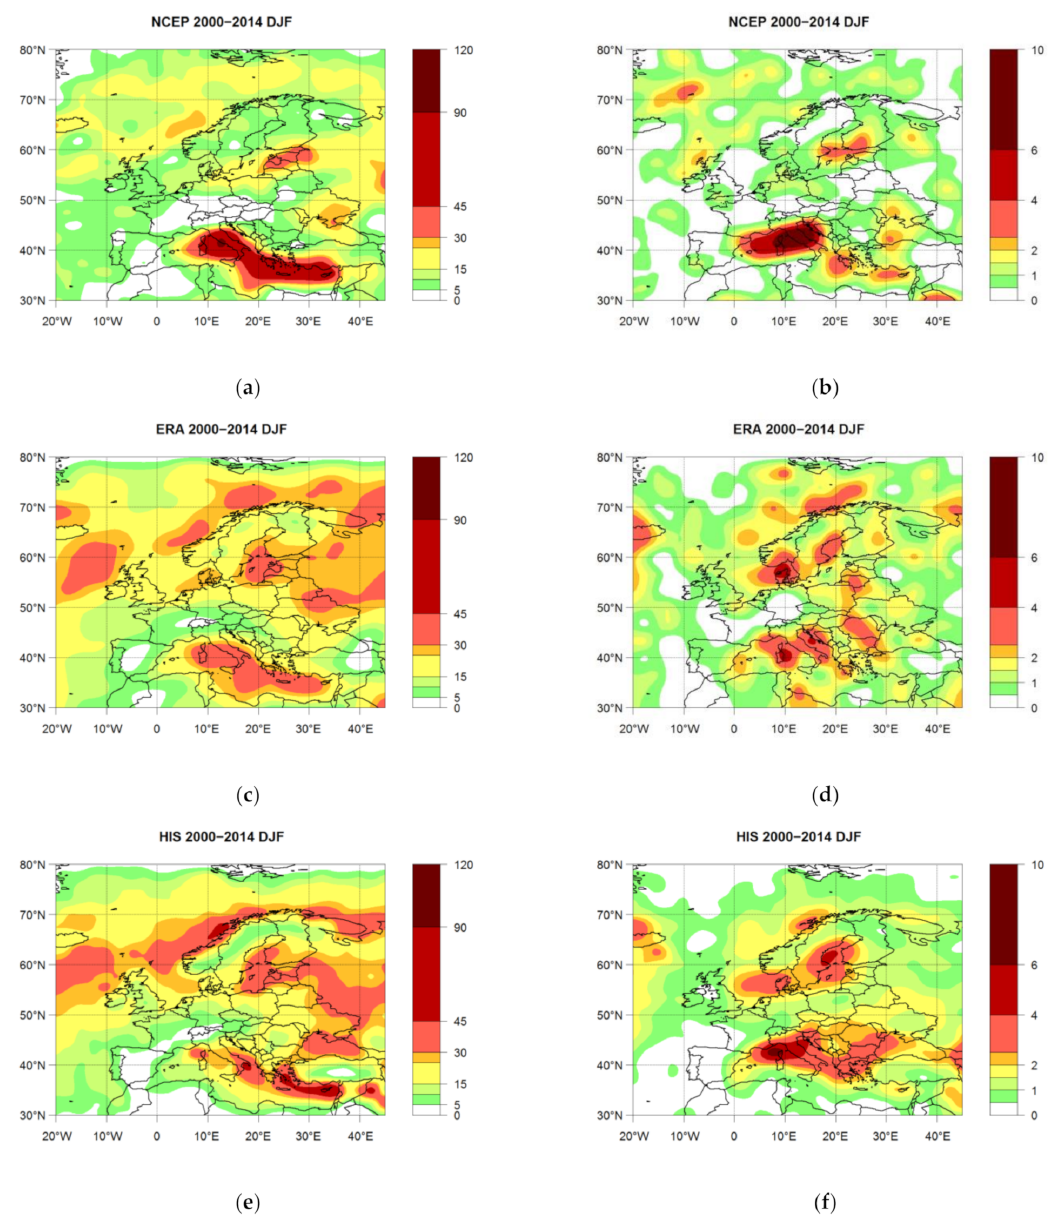
Figure 2. Winter cyclone numbers (total for 15 seasons) in the recent historical period (HIS, from 2000 to 2014): ( a , c , e ) frequency; ( b , d , f ) cyclogenesis events; based on: ( a , b ) NCEP/NCAR reanalysis; ( c , d ) ERA5 reanalysis; and ( e , f ) CMIP6